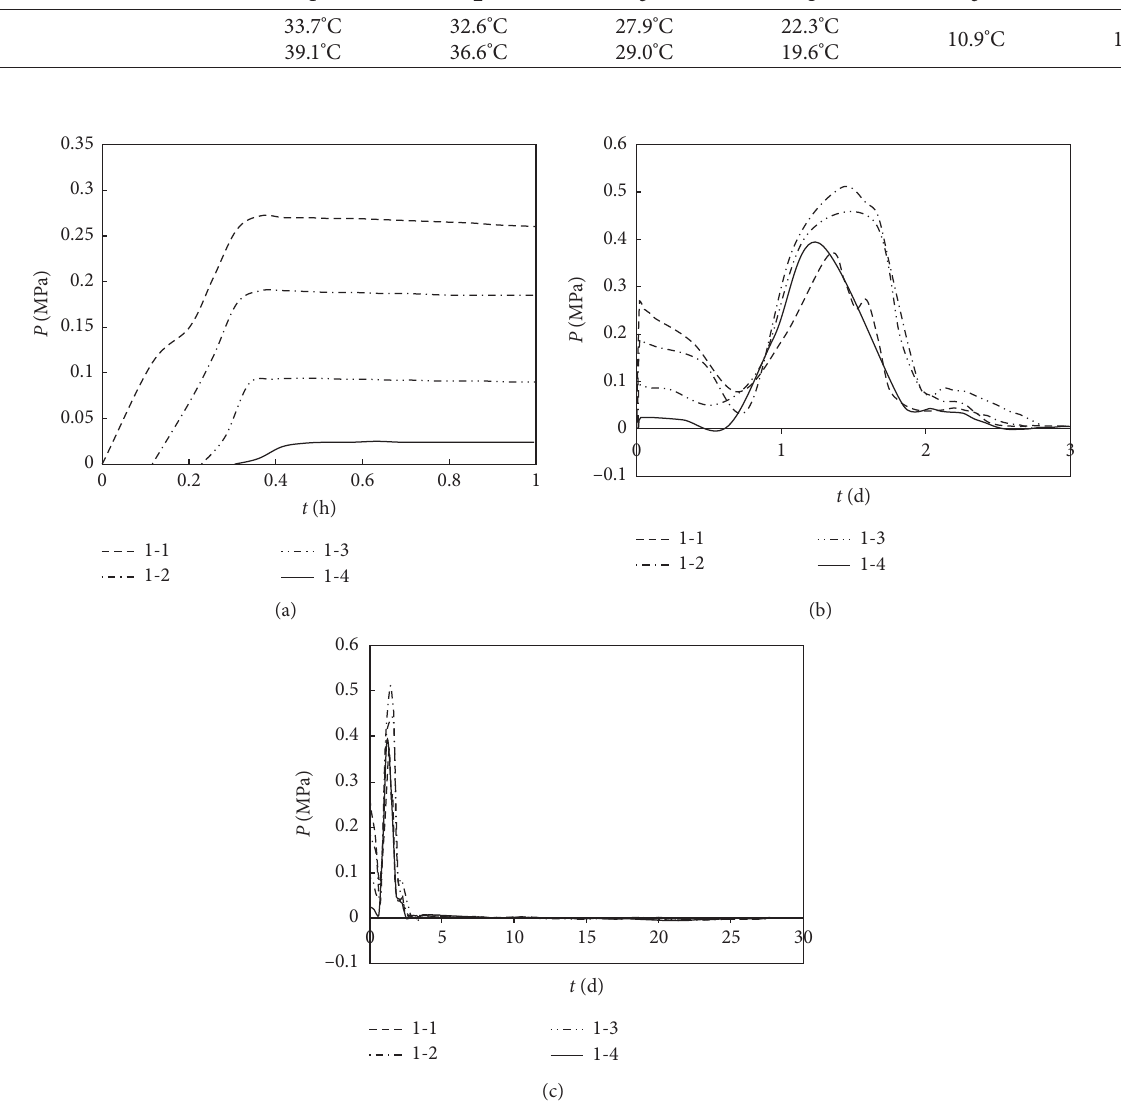
Figure 7: Test curves of pouring pressure and expansion stress of the core concrete for SYZ-1. (a) 1 hour. (b) 3 days. (c) 28